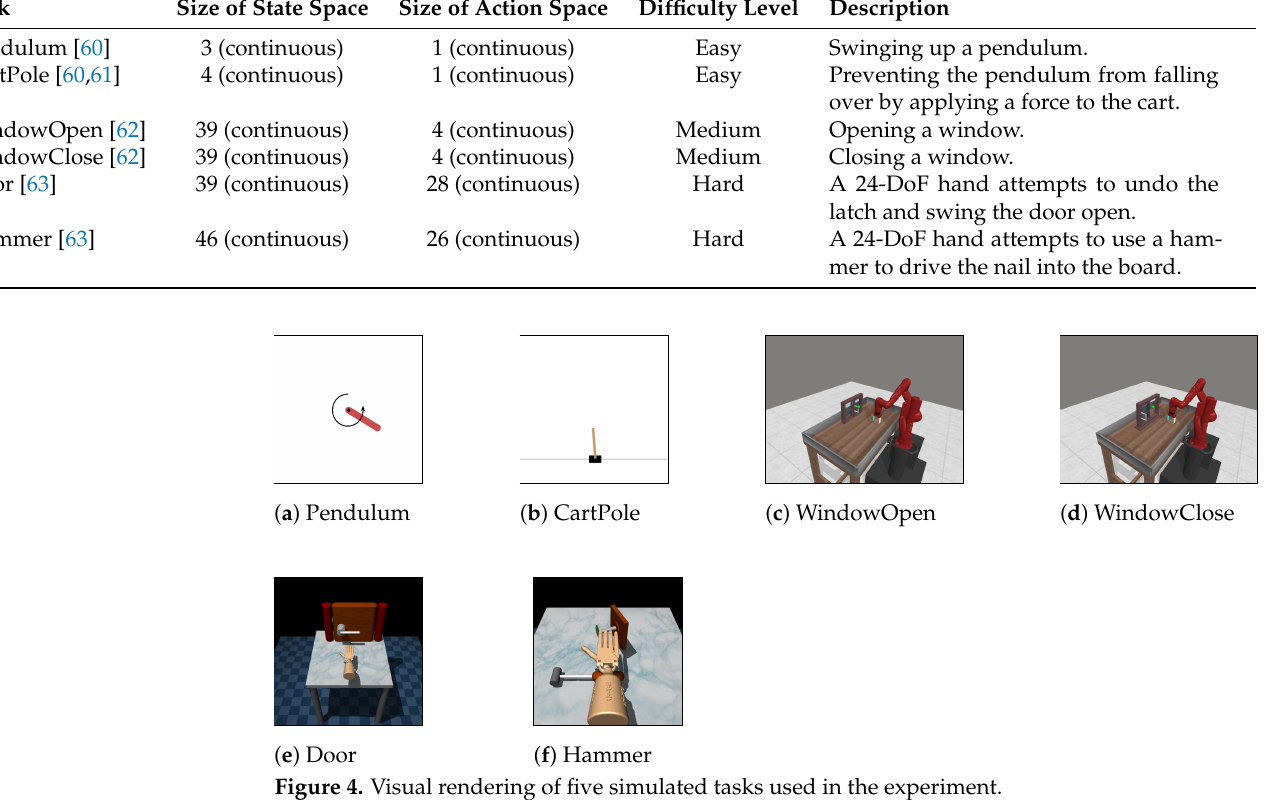
Figure 4. Visual rendering of five simulated tasks used in the experiment. Table 2. Description of three experiments conducted to evaluate the performance of the pro- posed